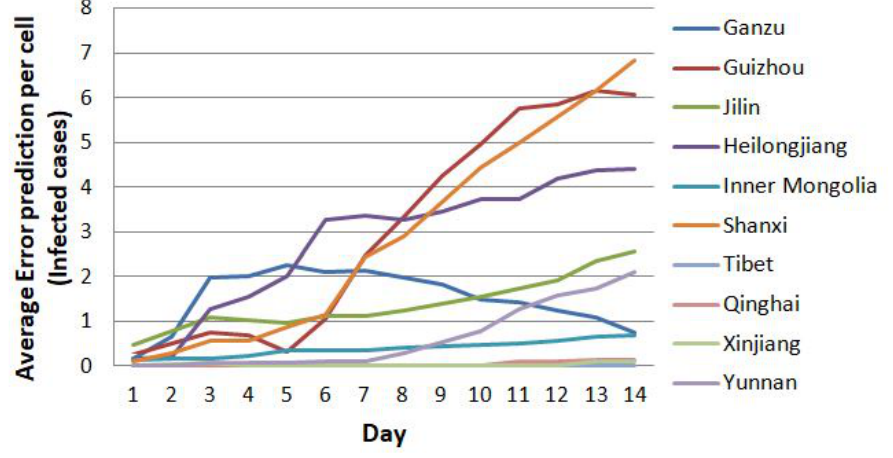
Figure 15. The trend of prediction error below 10 cases per cell until the 14th